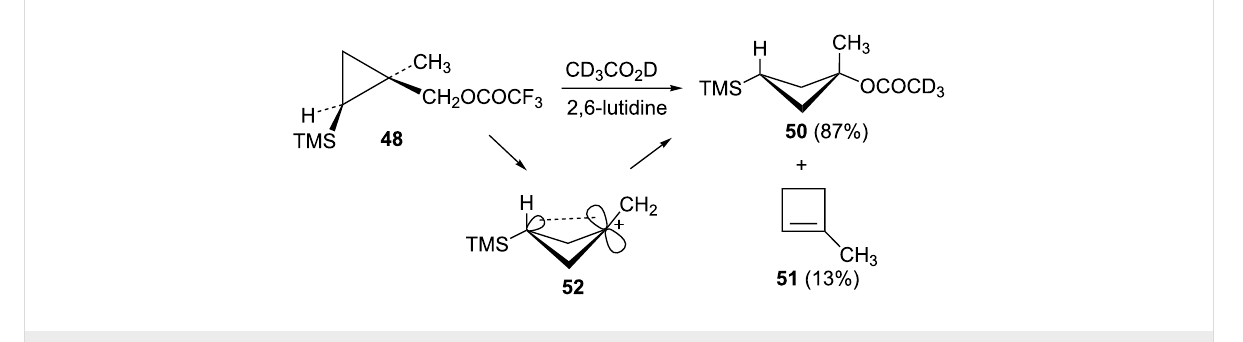
Scheme 10: Reaction of trifluoroacetate 48 in CD 3 CO 2